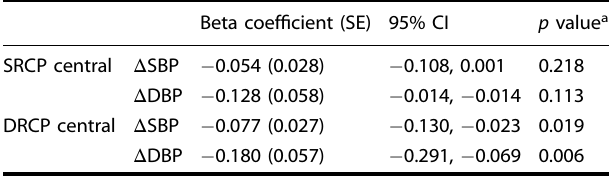
Table 3. Results of the linear mixed model